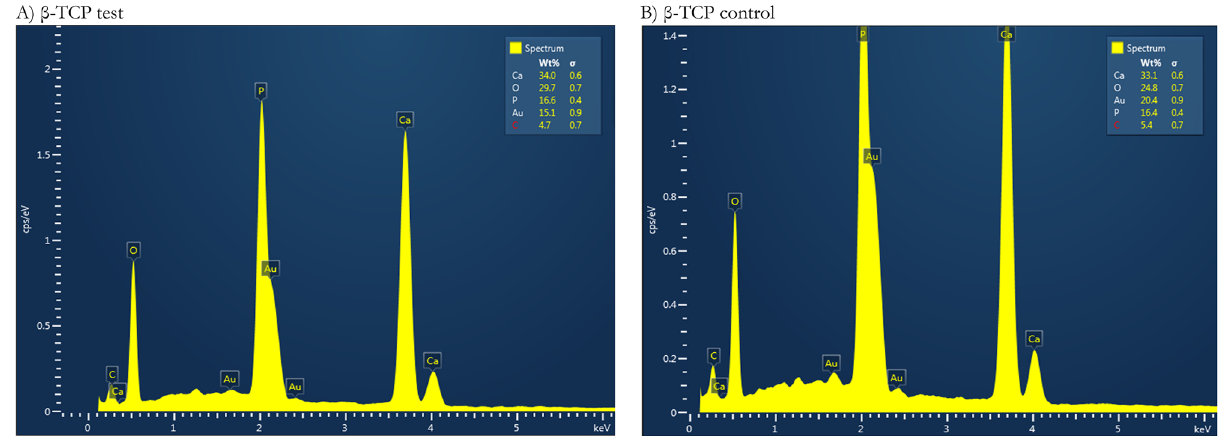
Figure 2. Energy-dispersive spectra (EX-250 SYSTEM, HORIBA, Kyoto, Japan). ( A ) β-TCP test and ( B ) β-TCP control samples.